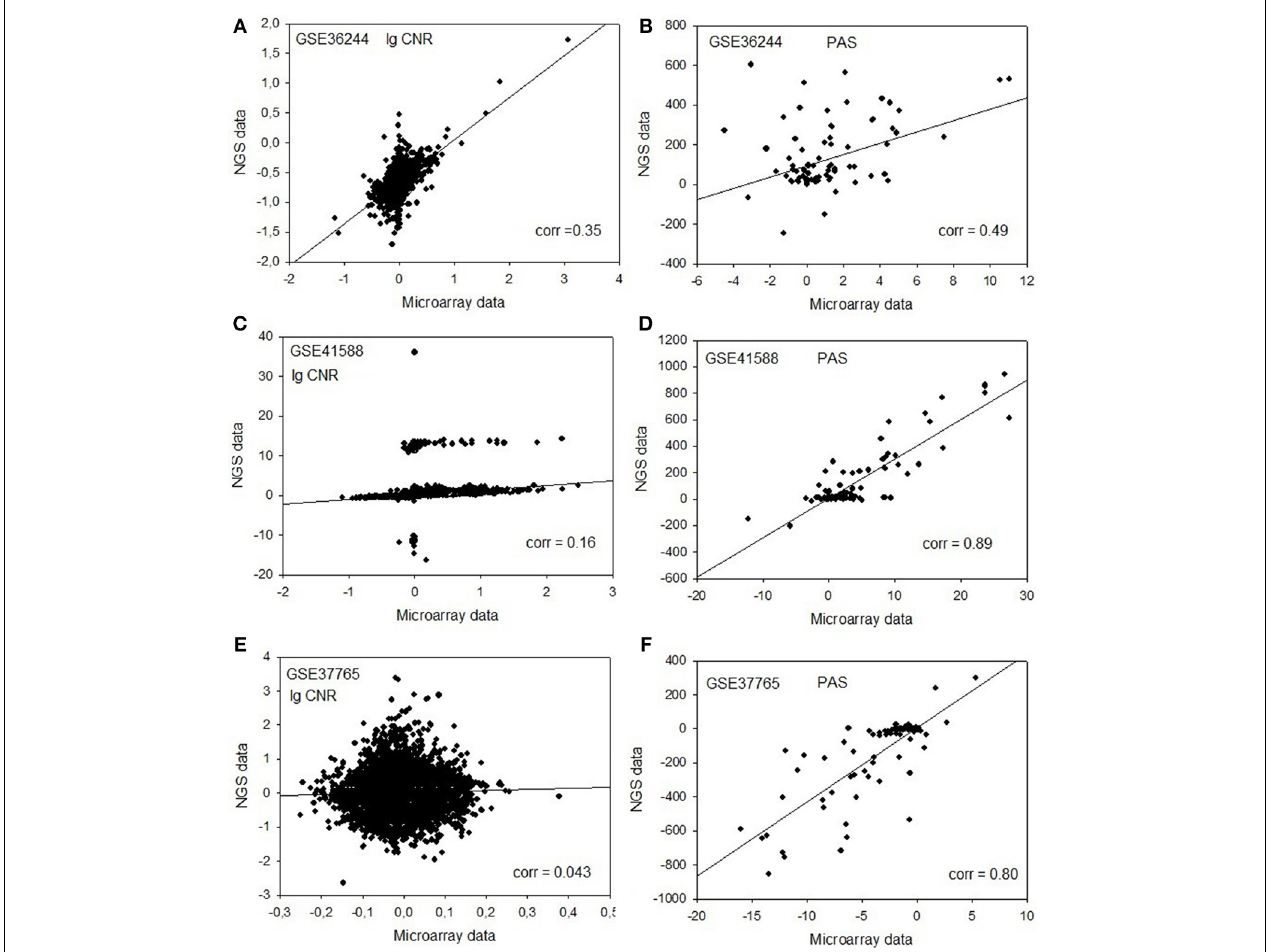
FIGURE 1 | Clouds of values obtained using the RNA next-generation sequencing vs. RNA microarray analysis methods. Upper row (A,B) : cell replica 1, 24h after BaP treatment from the HepG2 cells, dataset GSE36244 (van Delft et al., 2012). Middle row (C,D) : treatment with 5 µ M of 5-Aza and